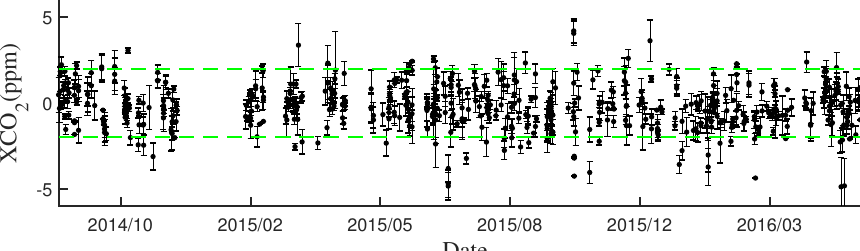
Figure 11. The time series of ∆ XCO 2 between GOSAT and OCO-2. The error bars indicate the standard deviation of ∆ XCO 2 within each GOSAT IFOV. The green dotted lines represent the threshold value of ± 2